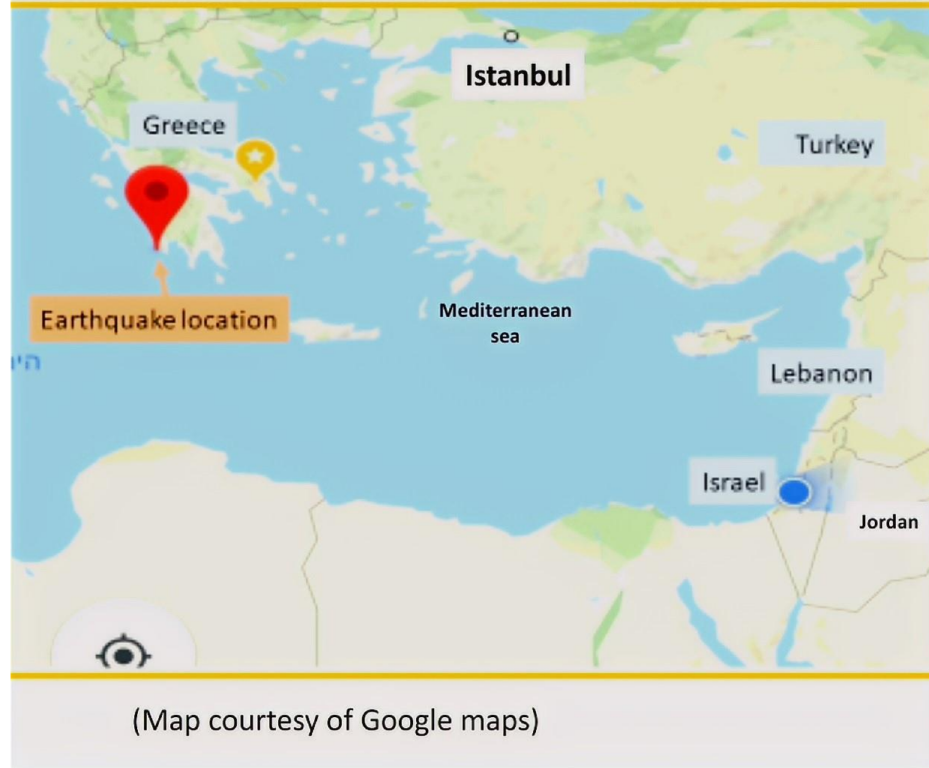
Figure 5. Location map of the 25 October 2018 earthquake south west of Greece. Origin time 22:54:51.80, lat. 37.47, long. 20.72, depth 16.8 km, mb 6.3, MS 6.9 [65,66].